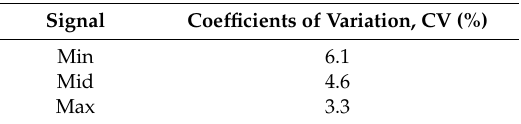
Table 2. Inter ‐ plate and Inter ‐ day tests for VP24 inhibition assay.